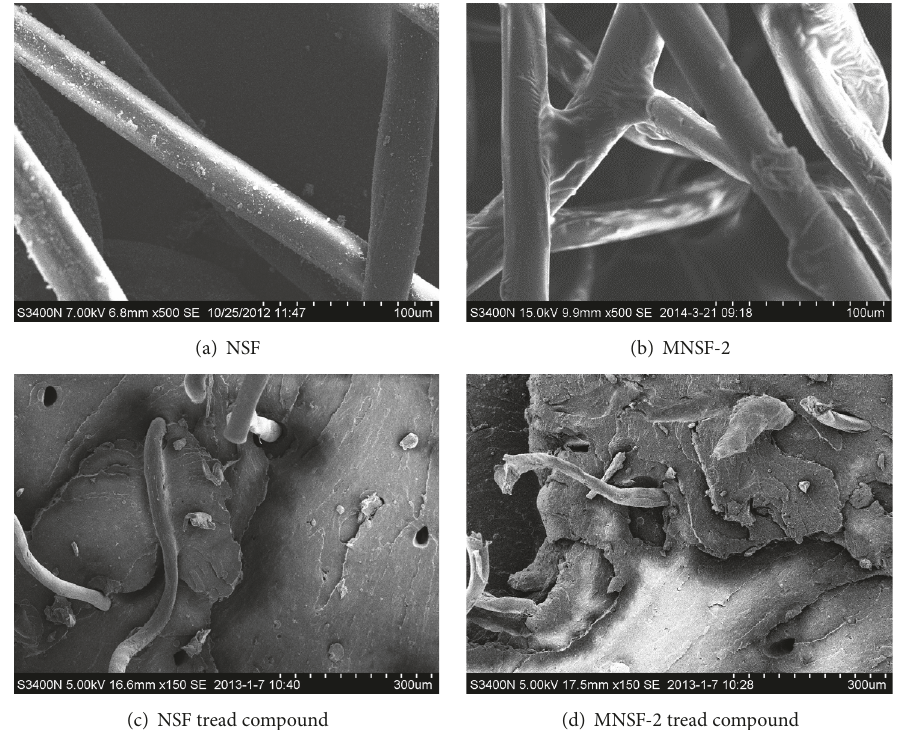
Figure 12: SEM of short fibers and tread